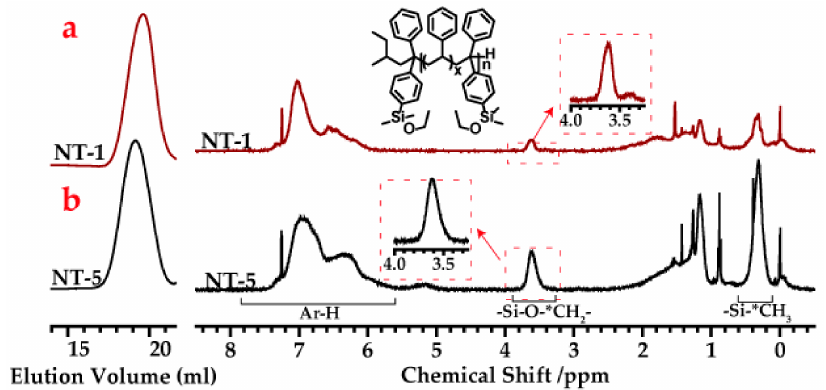
Figure 7. SEC chromatograms and 1 H NMR spectra of sample NT-1 ( a ) and sample NT-5 ( b